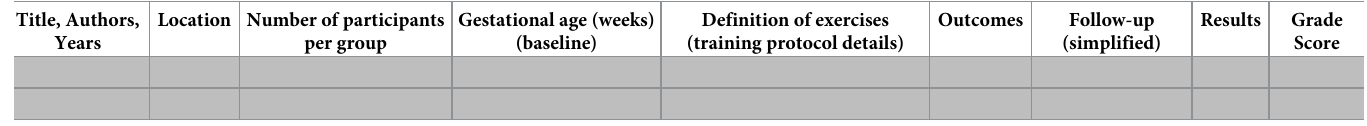
Table 2. Study characteristics related to the configuration; the number of participants according to the group; gestational age; exercise definition, outcome mea- sures for women; and follow up.